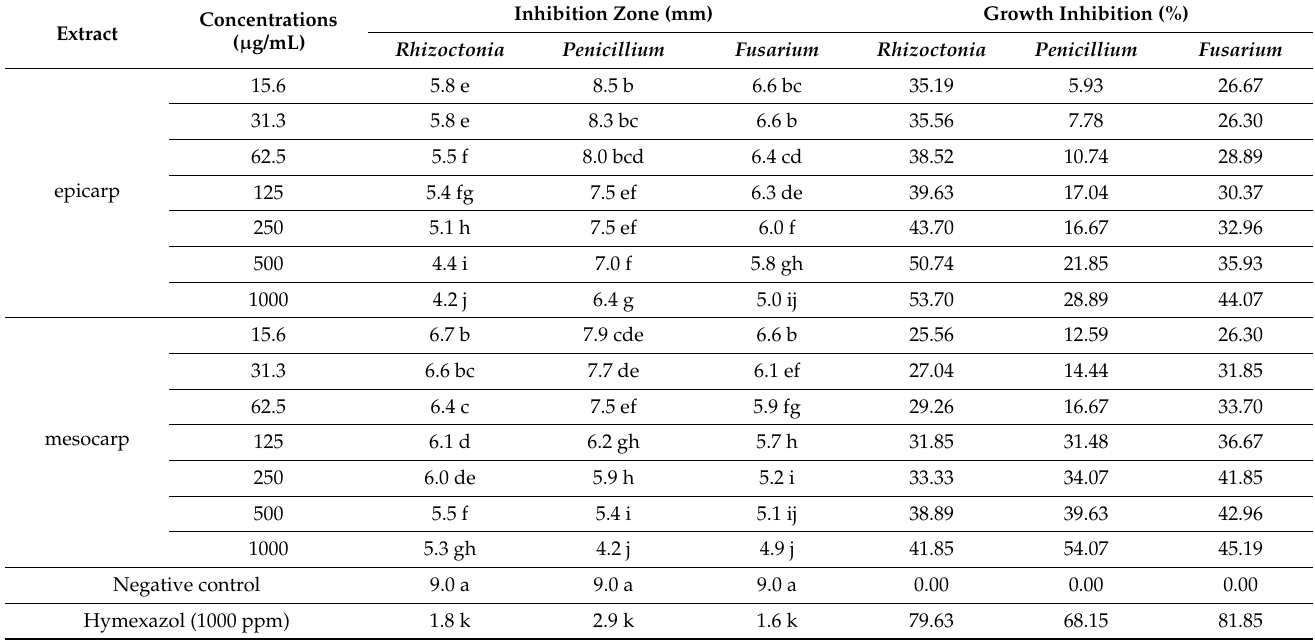
Table 5. Antifungal activities of methanol extract of neem fruit epicarp (epicarp) against Rhizoctonia solani, Penicillium italicum, and Fusarium oxysporium